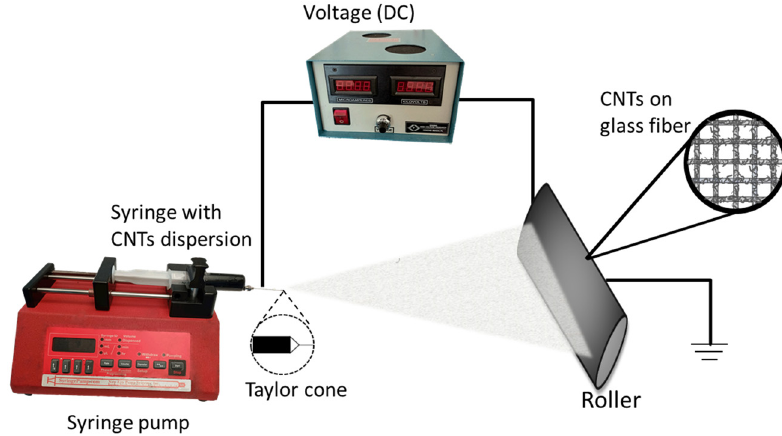
Figure 1: Illustration of ESD process.